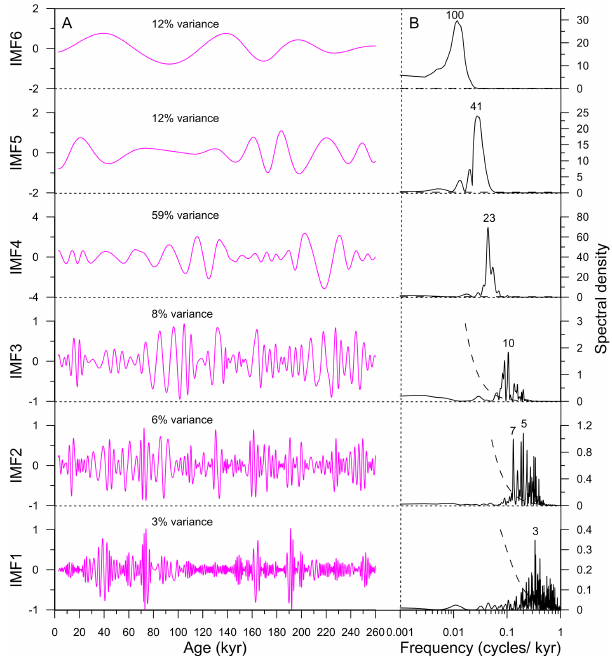
Figure 5. IMFs of speleothem δ 18 O series (a) and corresponding spectra (b) . Numbers in black are dominant periods and dotted lines represent the 90% confidence level.